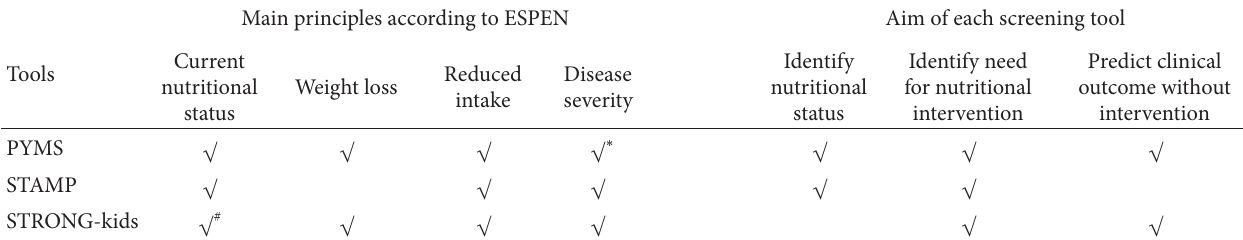
Table 5: Comparison of screening tools based on 4 main principles of a screening tool according to ESPEN [9, 10].